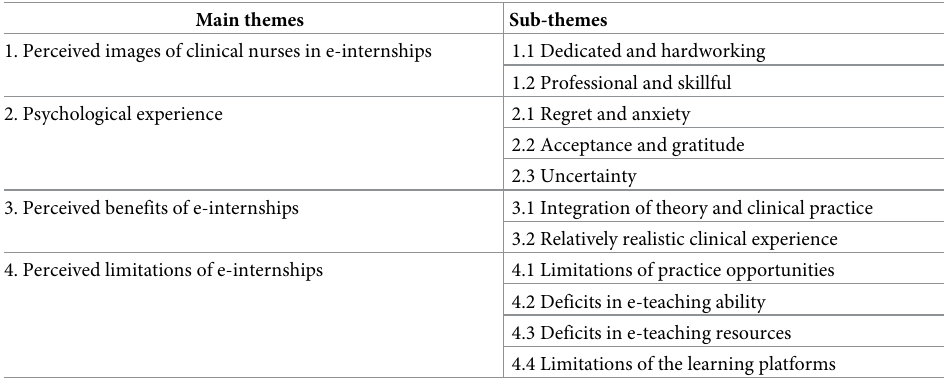
Table 3. Main themes and sub-themes identified in the